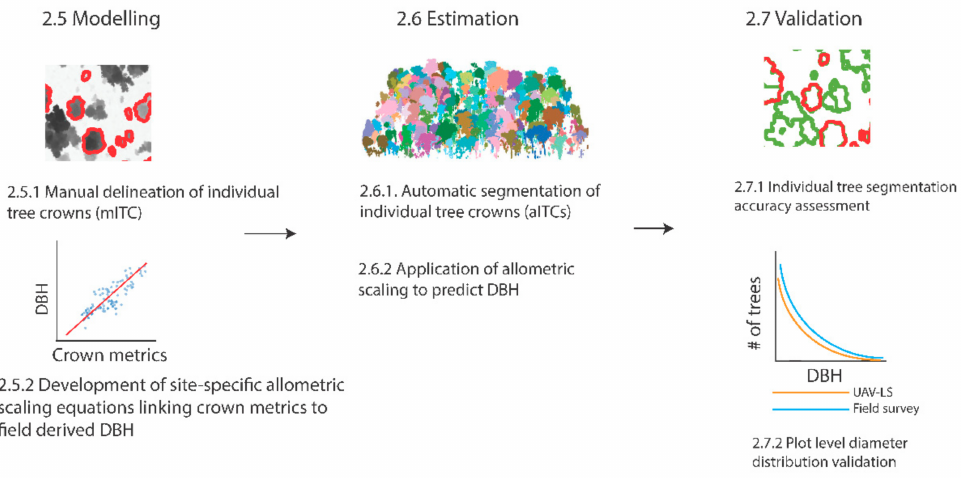
Figure 2. Overview of the methods workflow, with numbers referring to the relevant methods